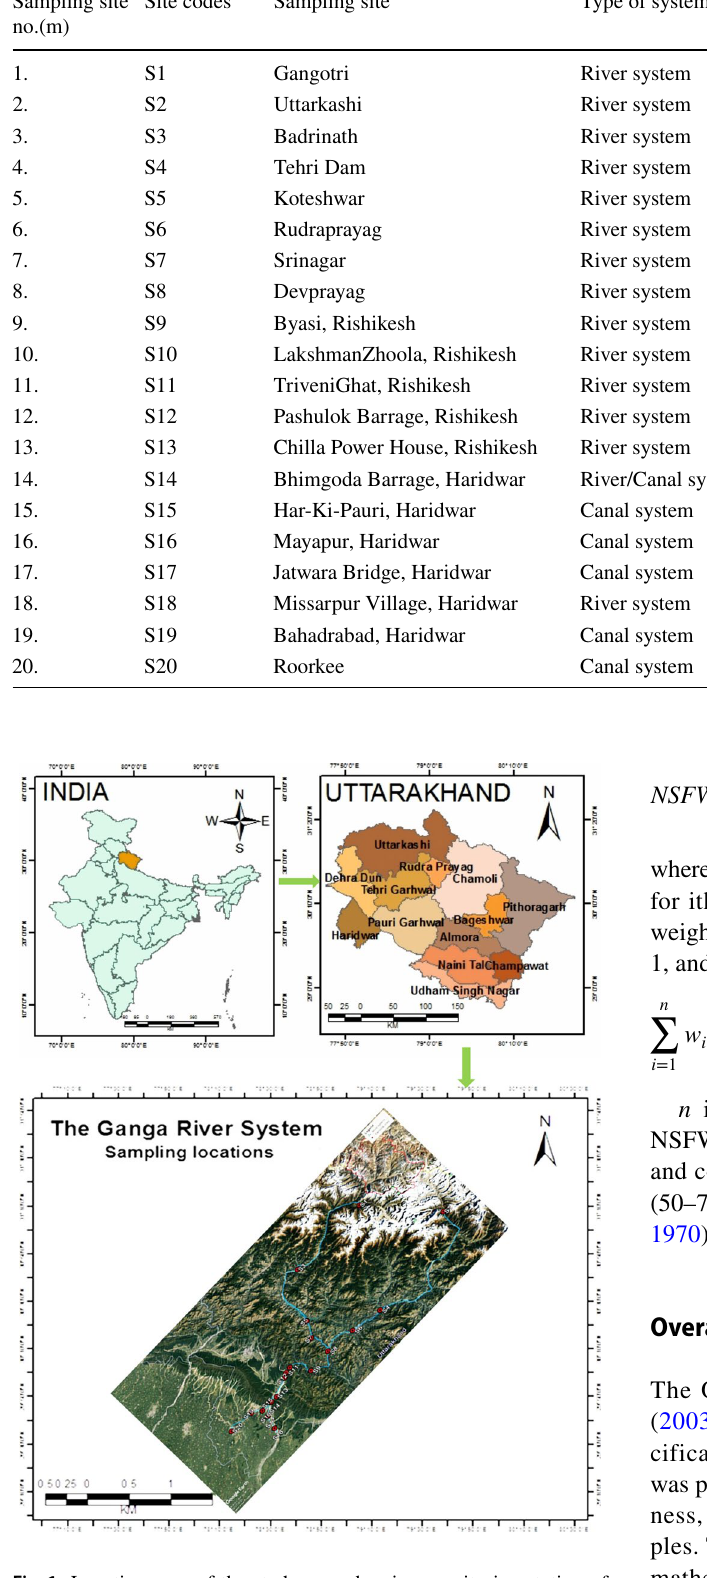
Fig. 1 Location map of the study area showing monitoring station of Ganga River